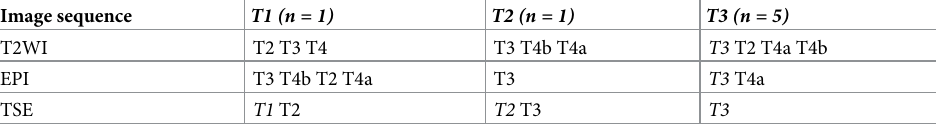
Table 5. T-stages diagnosed by 10 readers in descending order of frequency for 7 pathologically-proven T-stages. Image sequence T1 (n = 1) T2 (n = 1) T3 (n = 5) T2WI T2 T3 T4 T3 T4b T4a T3 T2 T4a T4b EPI T3 T4b T2 T4a T3 T3 T4a TSE T1 T2 T2 T3 T3 Pathologically-proven T-stages are in italic